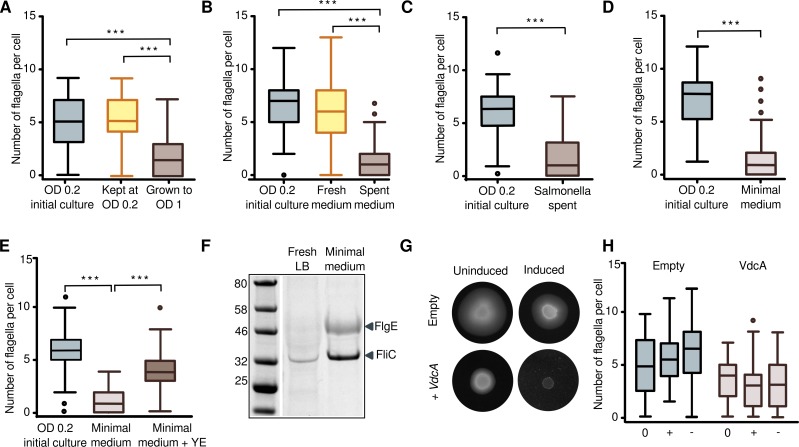
Ejection of the γ-proteobacterial flagellum is triggered by nutrient depletion.(A) Cells continually diluted to low cell density do not lose flagella (***P < 0.0001, one-way ANOVA). At least 65 cells were analyzed for each sample. (B) Low-OD cells moved from fresh LB to P. shigelloides spent medium lose flagella within one doubling time (***P < 0.0001, one-way ANOVA). The doubling rate was 2-fold lower for low cell density cells transferred to spent medium compared to those transferred to fresh LB. Ninety cells were analyzed from each sample. (C) Low-OD cells moved from fresh LB to Salmonella spent medium lose flagella within one doubling time (***P < 0.0001, unpaired t test). At least 75 cells were analyzed for each sample. (D) Cells eject flagella when transferred from LB to MOPS minimal medium (***P < 0.0001, unpaired t test). At least 60 cells were analyzed for each sample. (E) The ejection of flagella in minimal medium is rescued by the addition of yeast extract. More than 70 cells were imaged for each sample (***P < 0.0001, one-way ANOVA). (F) Supernatant of cells grown in minimal medium has detectable hook and more flagellin than the supernatant of cells grown in fresh LB. (G) Motility plates showing that cells harboring an over-expression plasmid for the c-di-GMP–synthesizing enzyme VdcA stop swimming but continue growing when induced. (H) Stopping swimming with increased levels of c-di-GMP is not due to ejection of flagella. 0 = prior to induction, - = not induced, + = induced. No significant difference was seen between the induced and not induced cells. Underlying data in S1 Data. c-di-GMP, cyclic di-GMP; FlgE, hook; FliC, filament; LB, Lysogeny Broth; OD, optical density.